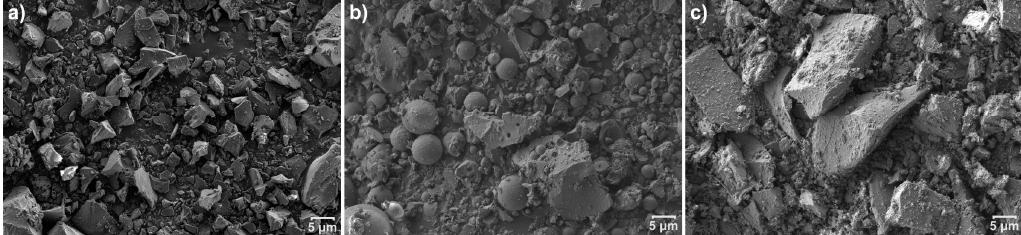
Figure 2. Images of the milled materials used as a precursor: ( a ) CSW; ( b ) FA; ( c ) BFS.